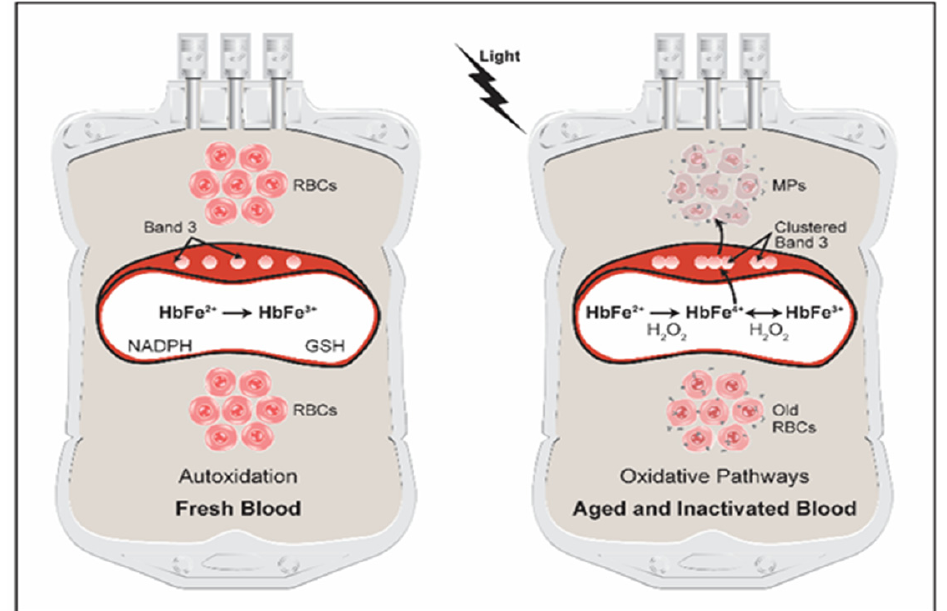
Figure 1. RBC oxidative injury during storage and pathogen inactivation conditions. Freshly stored RBCs in a standard blood bag undergo very little oxidation apart from normal spontaneous (autox- idation) reactions of Hb, resulting in little metHb accumulation (left). Reductive and antioxidant enzymes/proteins such as NADPH reductase and GSH maintain metHb to a minimum. Under prolonged storage conditions or when RBCs are exposed to UV light, Hb oxidative side reactions are increased, mainly Hb’s own pseudoperoxidative pathways (right). These pathways result in the production of ferryl Hb (HbFe 4+ ) which attacks other biological targets including band 3, resulting in band 3 clustering. Ferryl Hb crosslinks the major RBC membranes band 3 into clusters and the ultimate release of Hb-laden microparticles (MPs), based on [18,37] with